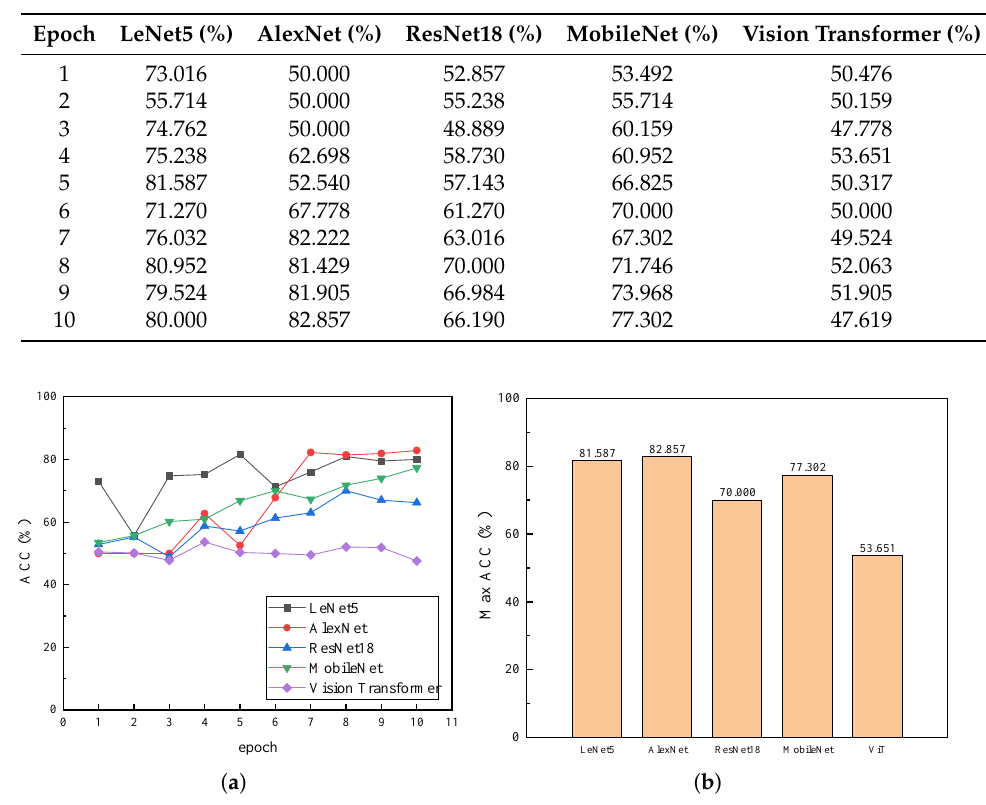
Table 10. Accuracy of pneumonia identification by each model after data augmentation and after GPU loading.